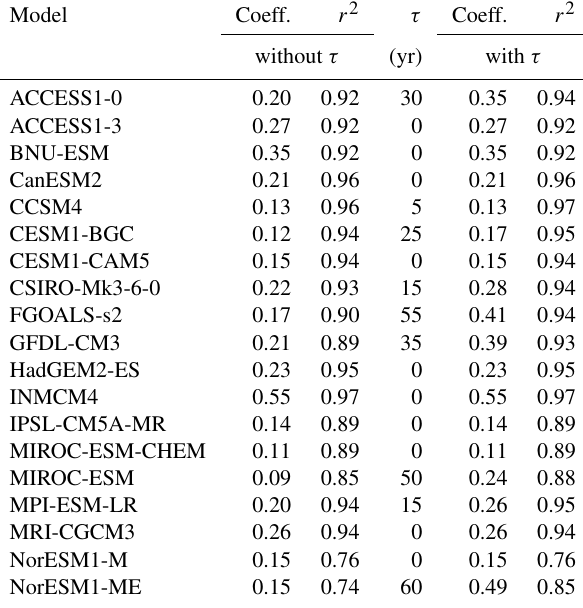
Table 2. East Antarctic sector: scaling coefficients, α r , and time delay, τ r , between increases in global mean temperature and sub- surface ocean temperature anomalies.